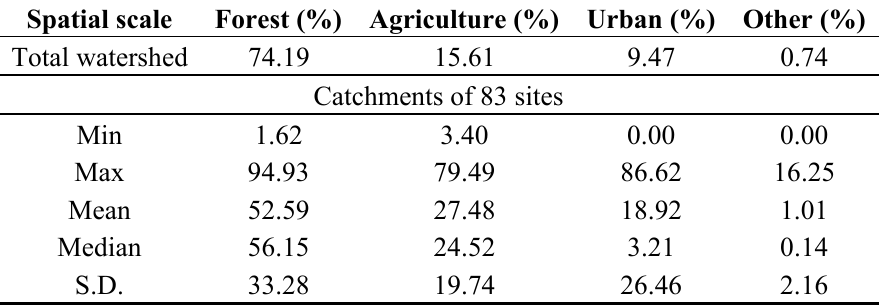
Table 1. Descriptive statistics for the land use characteristics in the Dongjiang River